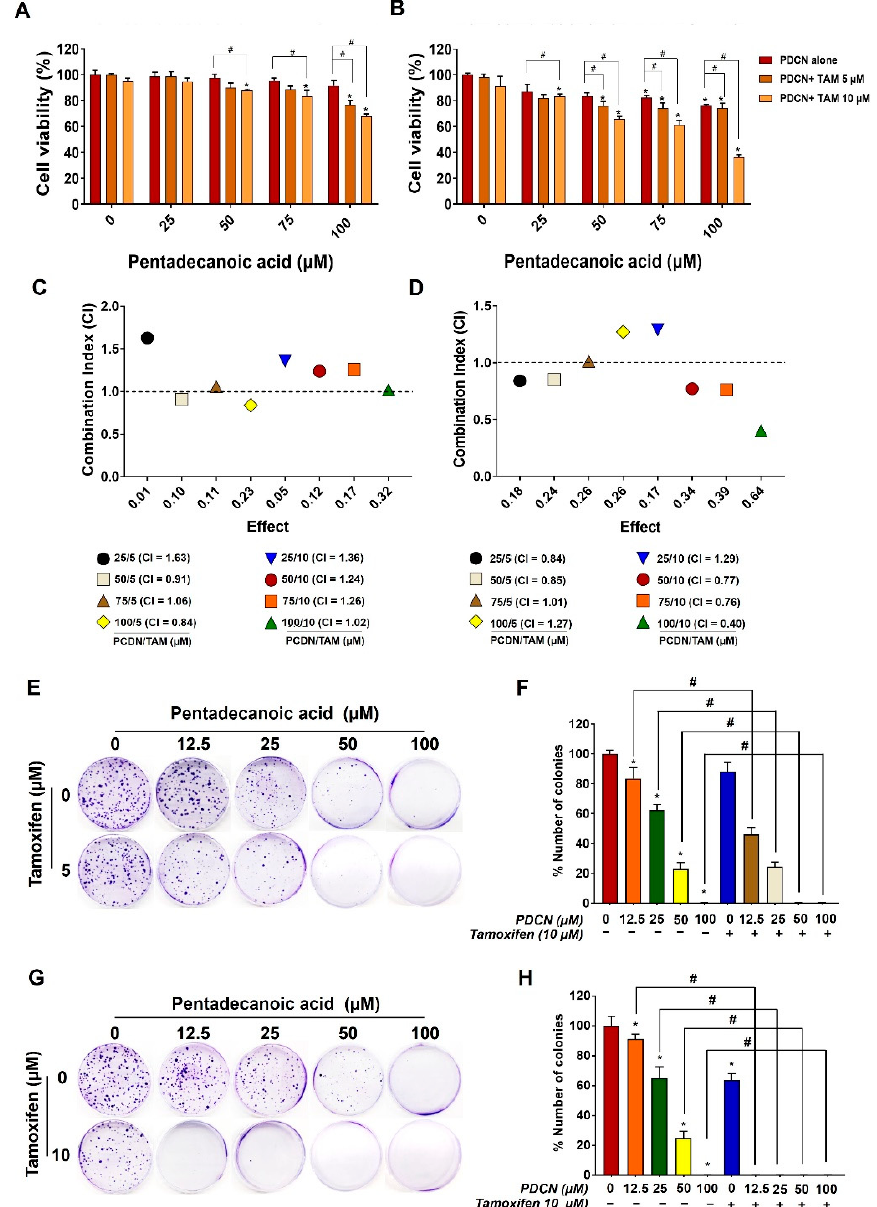
Figure 3. Synergistic effect of combined treatment of pentadecanoic acid and tamoxifen in MCF − 7/SC cells. Cell viability was assessed using the MTT assay with pentadecanoic treatment alone or in combination with tamoxifen (0 μ M, 5 μ M, and 10 μ M) at ( A ) 24 h and ( B ) 48 h. CI values were calculated after combined treatment at ( C ) 24 h and ( D ) 48 h in MCF − 7/SC cells. Effects of pentadecanoic acid and tamoxifen treatment alone at 5 μ M ( E , F ) and 10 μ M ( G , H ) or their combination on colony formation of MCF − 7/SC cells. The asterisk (*) indicates p < 0.05 vs. the control. The hash mark (#) indicates p < 0.05 when comparing combined treatment vs. individual treatment. PDCN: pentadecanoic acid; Tam: tamoxifen. The CI values illustrated in the graph are the mean from three independent experiments. Data are representative of three biologically independent experiments and values are shown in mean ± SD.